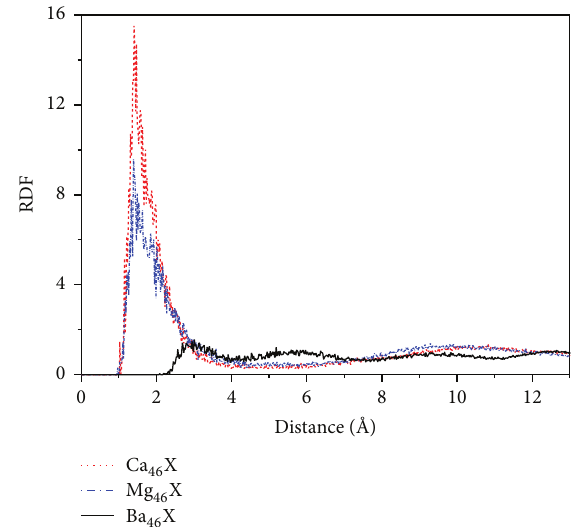
Figure 9: Radial distribution functions of the centers of mass for hydrogen molecules in three zeolites at 77K and 10